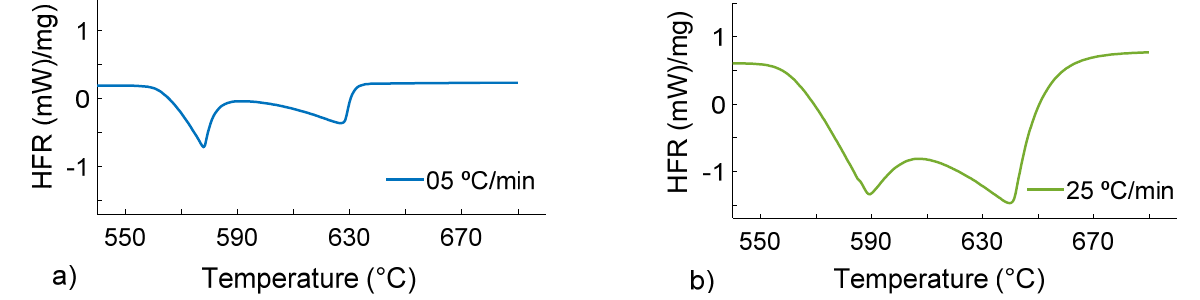
Figure 3. DSC heat flow rate ( y -axis) vs. temperature ( x -axis) curves during melting of the Al 4 Si 4 Zn alloy at 5 ( a ) and 25 ( b ) ◦ C/min with a DSC sample mass of 90